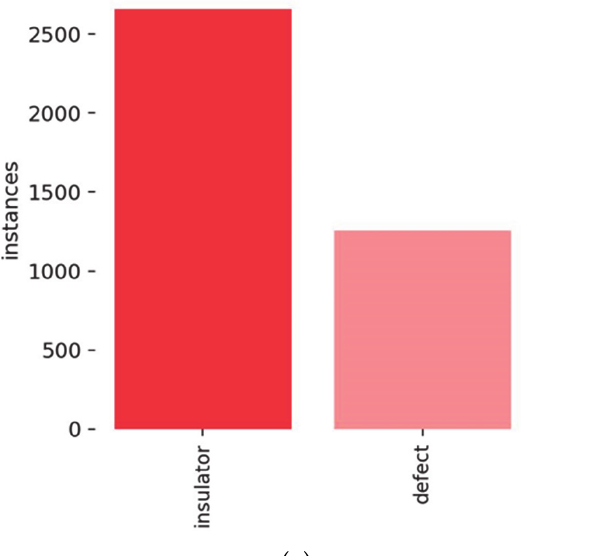
Figure 4. Data-enhanced renderings. ( a ) Original. ( b ) Random brightness. ( c ) Rotated. ( d ) Random translate.